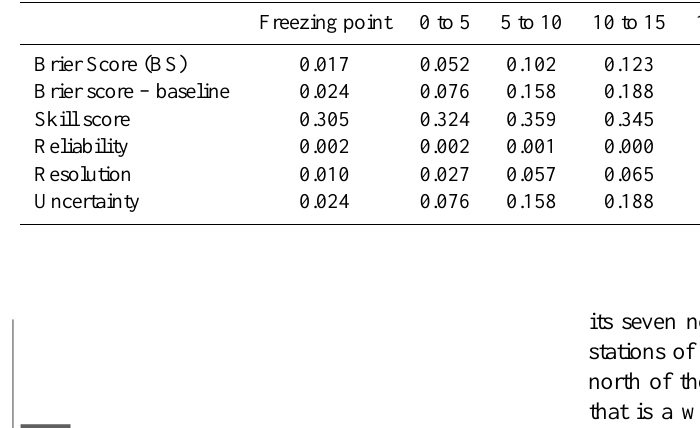
Table 3. Performance scores for eight categories ranging from “equal to 0 ◦ C” out to “above 30 ◦ C” with 5 ◦ C interval.